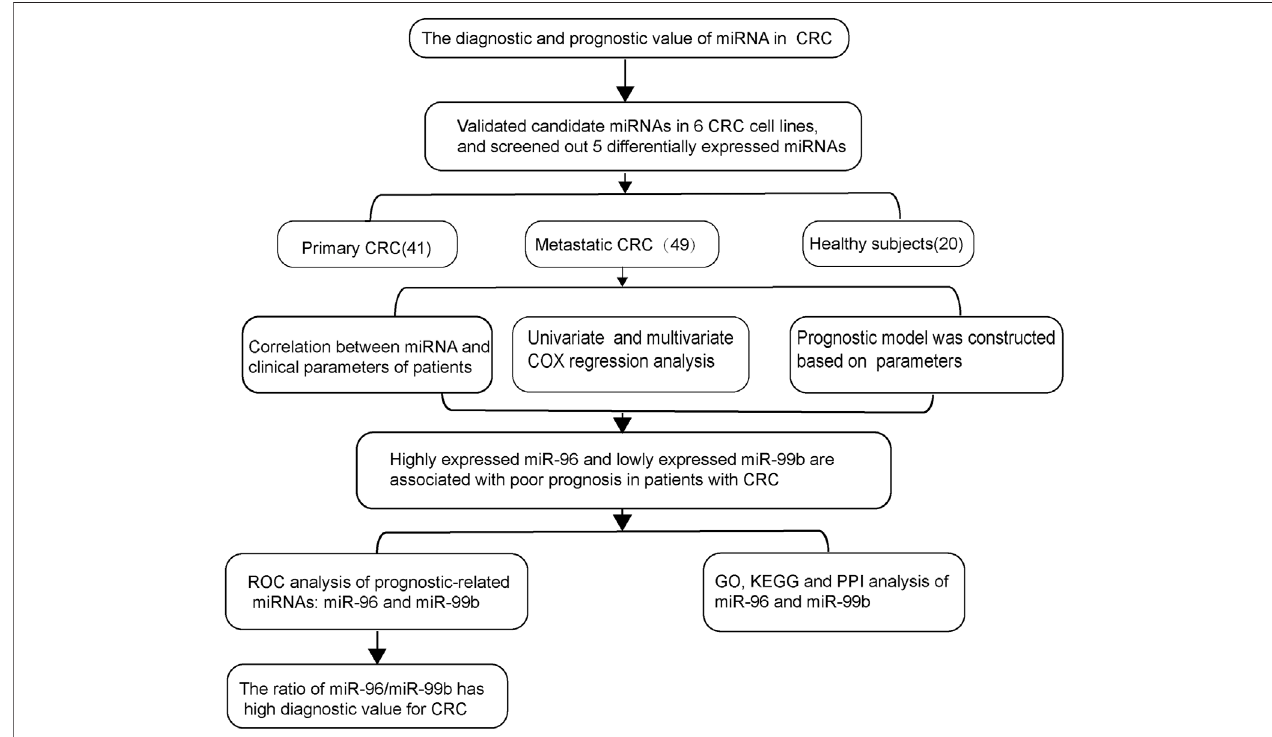
FIGURE 1 | The work fl ow of the entire